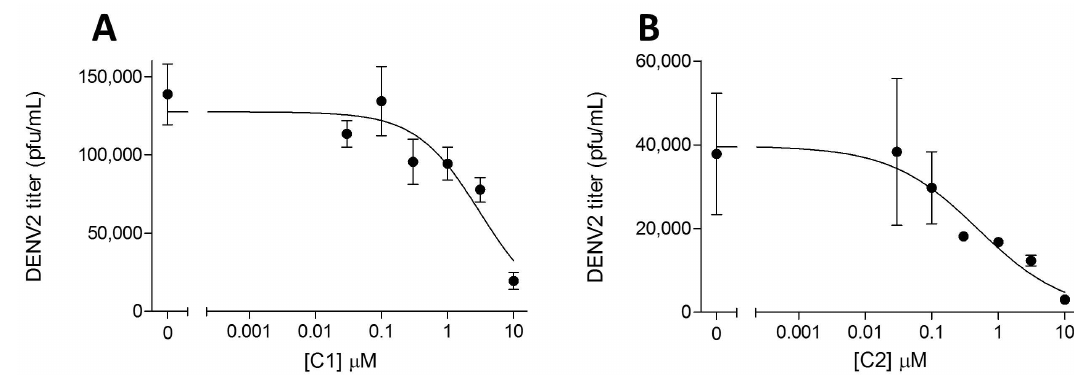
Figure 1. Quinoline derivatives 1 (panel A ) and 2 (panel B ) are active against DENV2 in a dose-dependent manner. Cells were infected with DENV2 and treated with several concentrations of either compound 1 (C1), compound 2 (C2), or dimethyl sulfoxide (DMSO) at equivalent concentration, as described in Materials and Methods. Forty-eight hours post infection, supernatants were collected, and viral titers determined by plaque assays. Data is expressed as mean ± standard error of three independent experiments. The curve was obtained by nonlineal regression analysis (four parameters logistic, variable slope model) as implemented in GraphPad Prism (GraphPad Software, La Jolla, CA, USA).